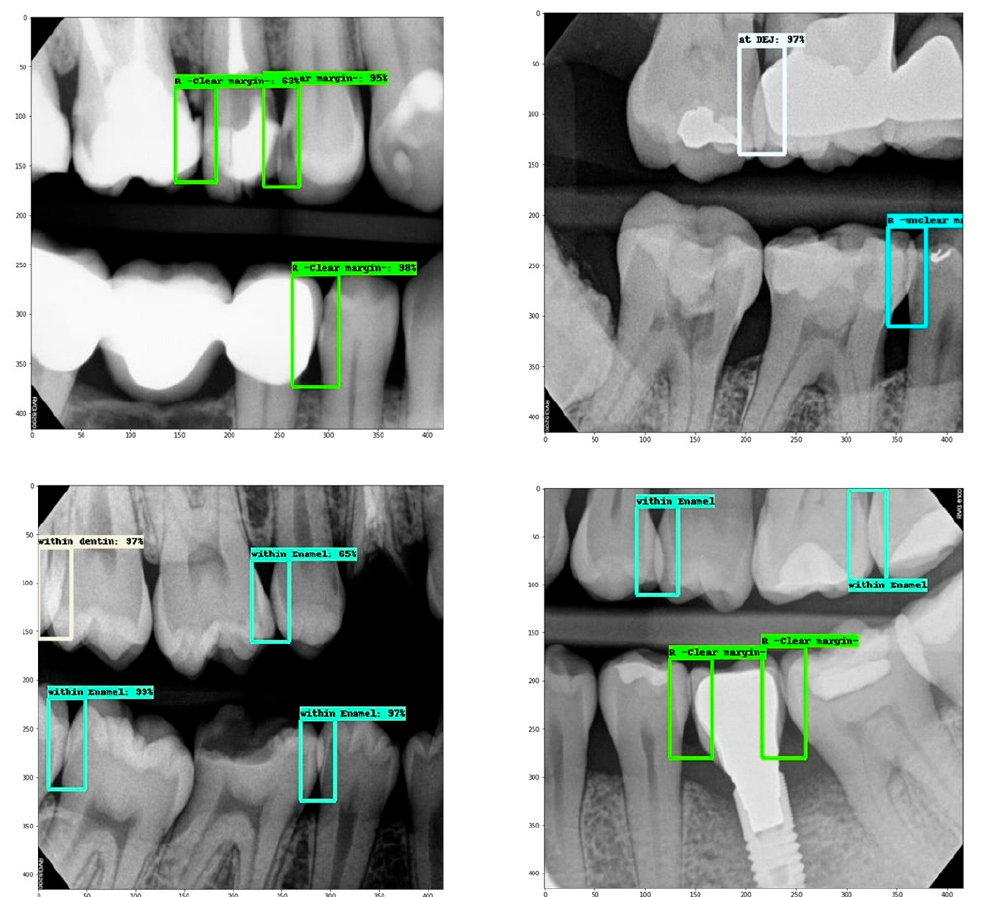
Figure 2. Representative samples of assessed contact area overlap; Cyan box: within enamel, White box: at DEJ, Off-white box: within dentin, Green box: within restoration (clear margins), Blue box: within restoration (unclear margins).